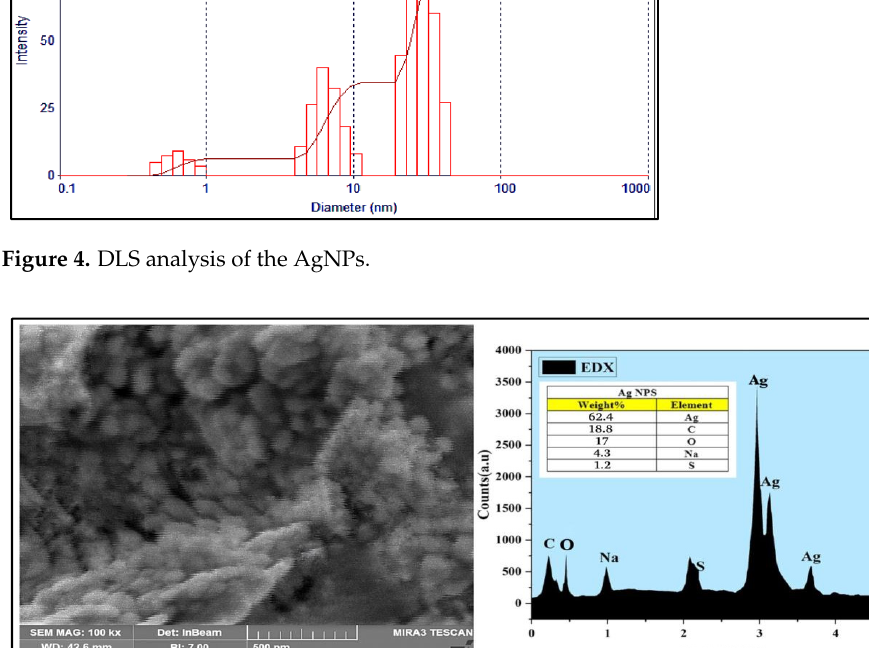
Figure 5. SEM and EDX analyses of the AgNPs.